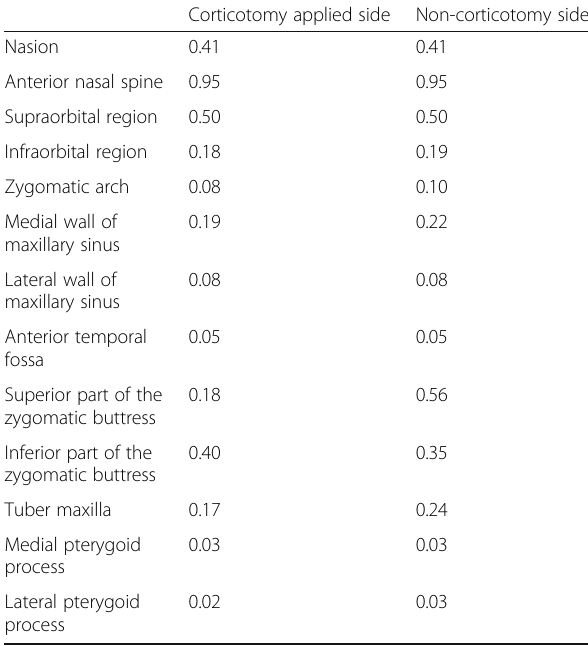
Table 2 The highest Von Mises stress levels calculated on some anatomical regions during force